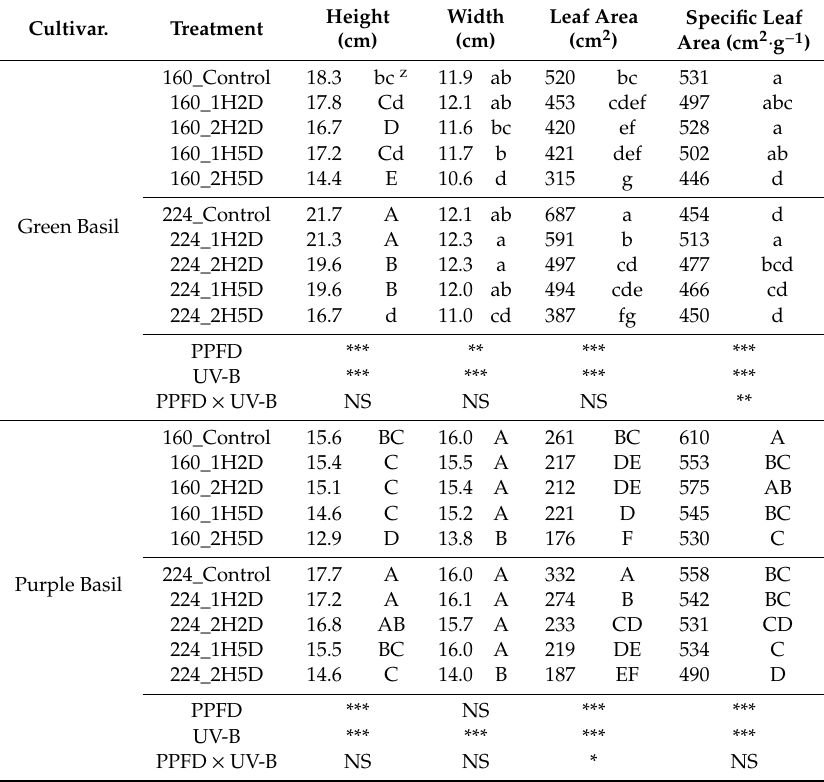
Table 2. Plant height, width, leaf area, and specific leaf area of green basil ‘Improved Genovese Compact’ and purple basil ‘Red Rubin’ plants under di ff erent treatments. There were 10 treatments created by the combination of two photosynthetic photon flux density (PPFD) levels of 160 and 224 µ mol · m − 2 · s − 1 and five UV-B irradiation treatments including control, 1H2D, 2H2D, 1H5D, 2H5D. Cultivar.